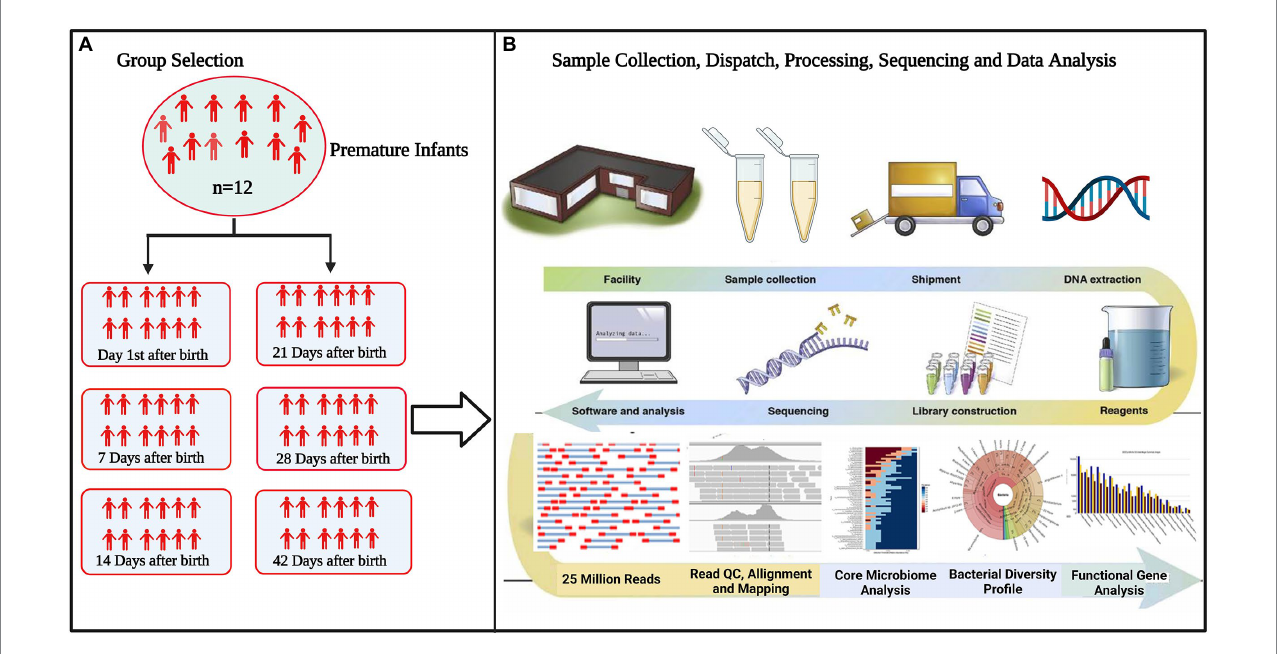
FIGURE 1 Flowchart of the study (A) selection of experimental groups to determine differences in microbiota between groups (B) standardizing technical factors and sample processing to control for variation introduced by every step of the process. Data interpretation necessitates the collection and curation of metadata about all aspects of each sample, from clinical variables to sample